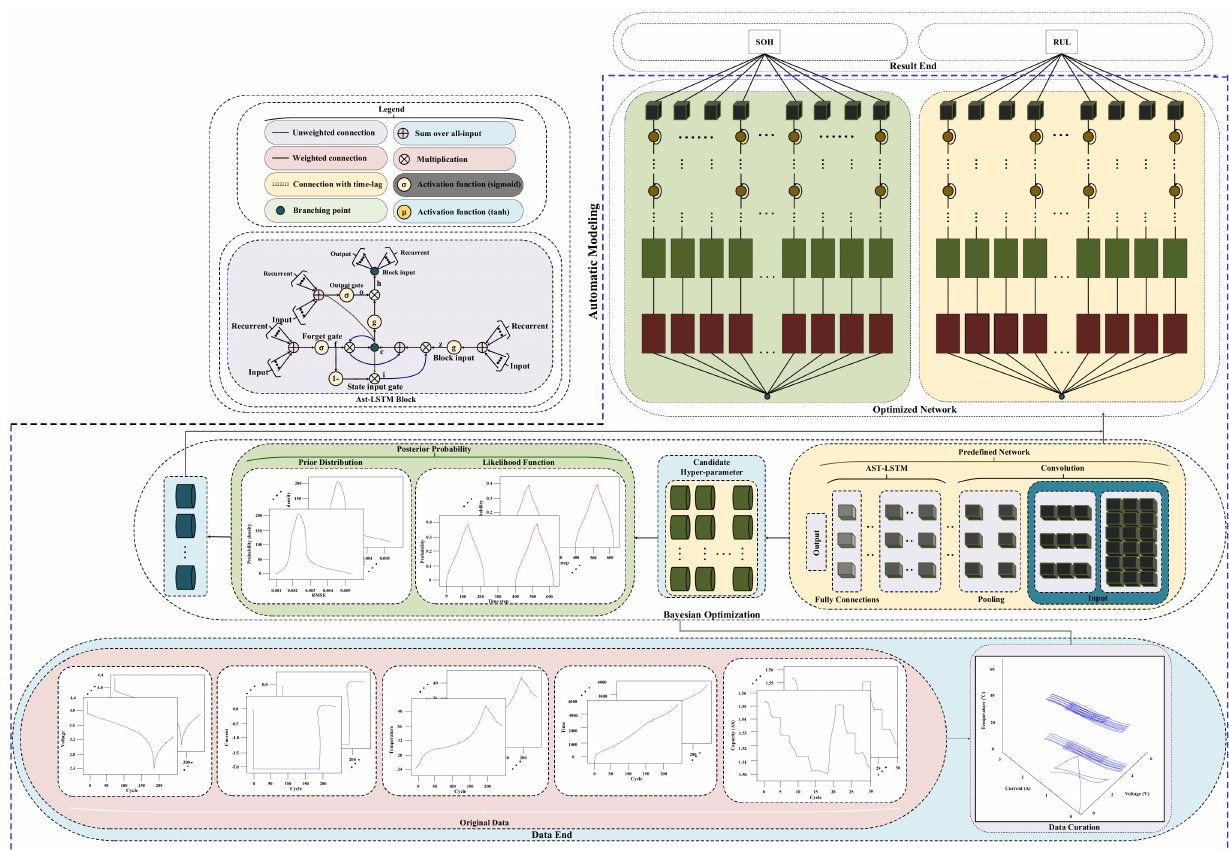
Figure 10. End-to-end prognostic framework of CNN-LSTM based model for SOH and RUL predic- tion of